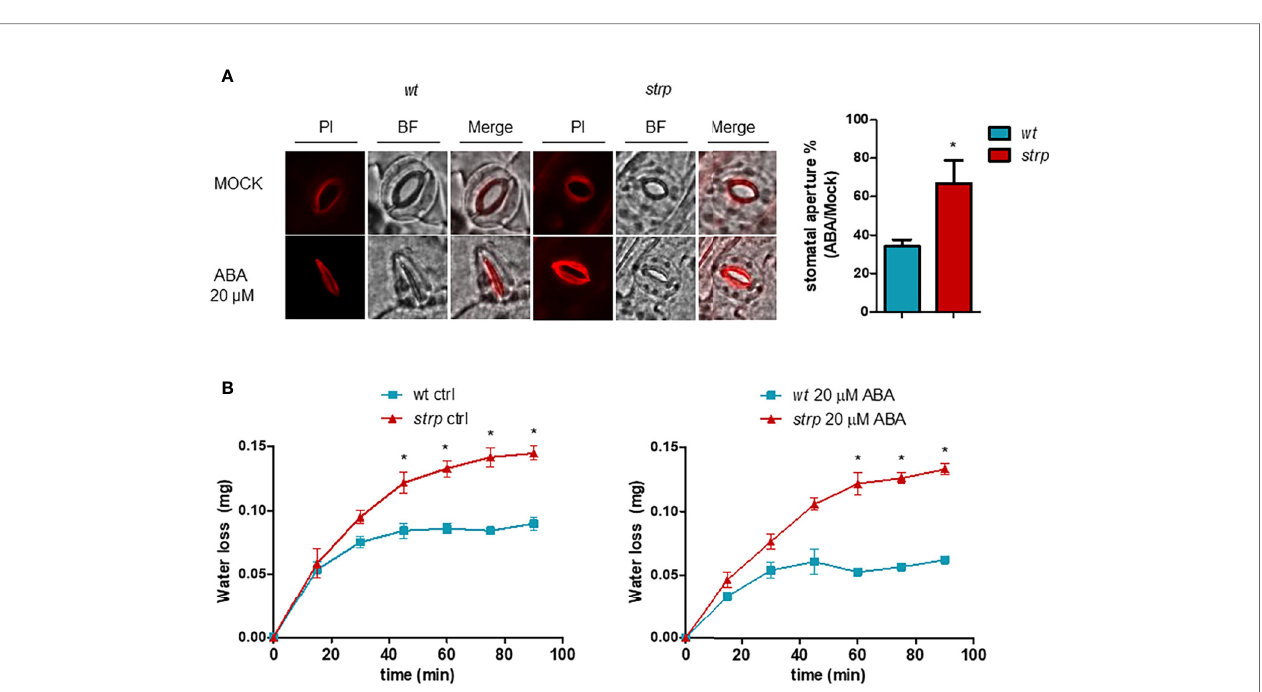
FIGURE 9 | The s trp mutation alters the ABA-induced stomatal closure and increases water loss by transpiration. (A) ABA-mediated stomatal closure, evaluated by treating the leaves with 20 µM ABA for 2 h. Epidermis was then isolated and stained with propidium iodide. (B) water loss was detected on strp and wild type detached leaves treated with 20 µM of ABA. Data are represented as variation of fresh weight respect to T0. Error bars are S.E.M. of three independent experiments. *P < 0.01, by Student ’ s